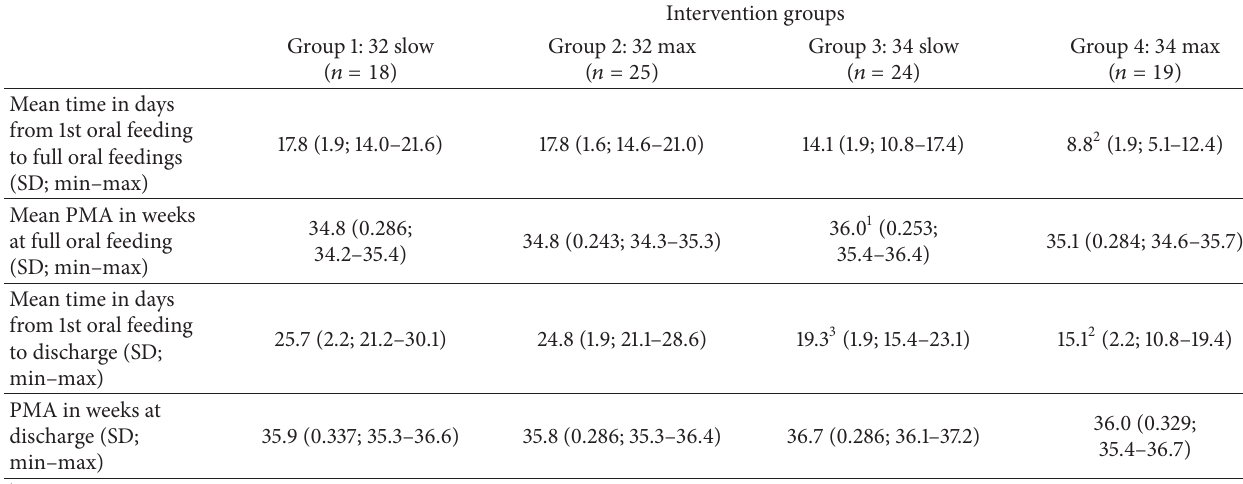
Table 3: PMA and time in days to full oral feeding and discharge from first oral feeding.